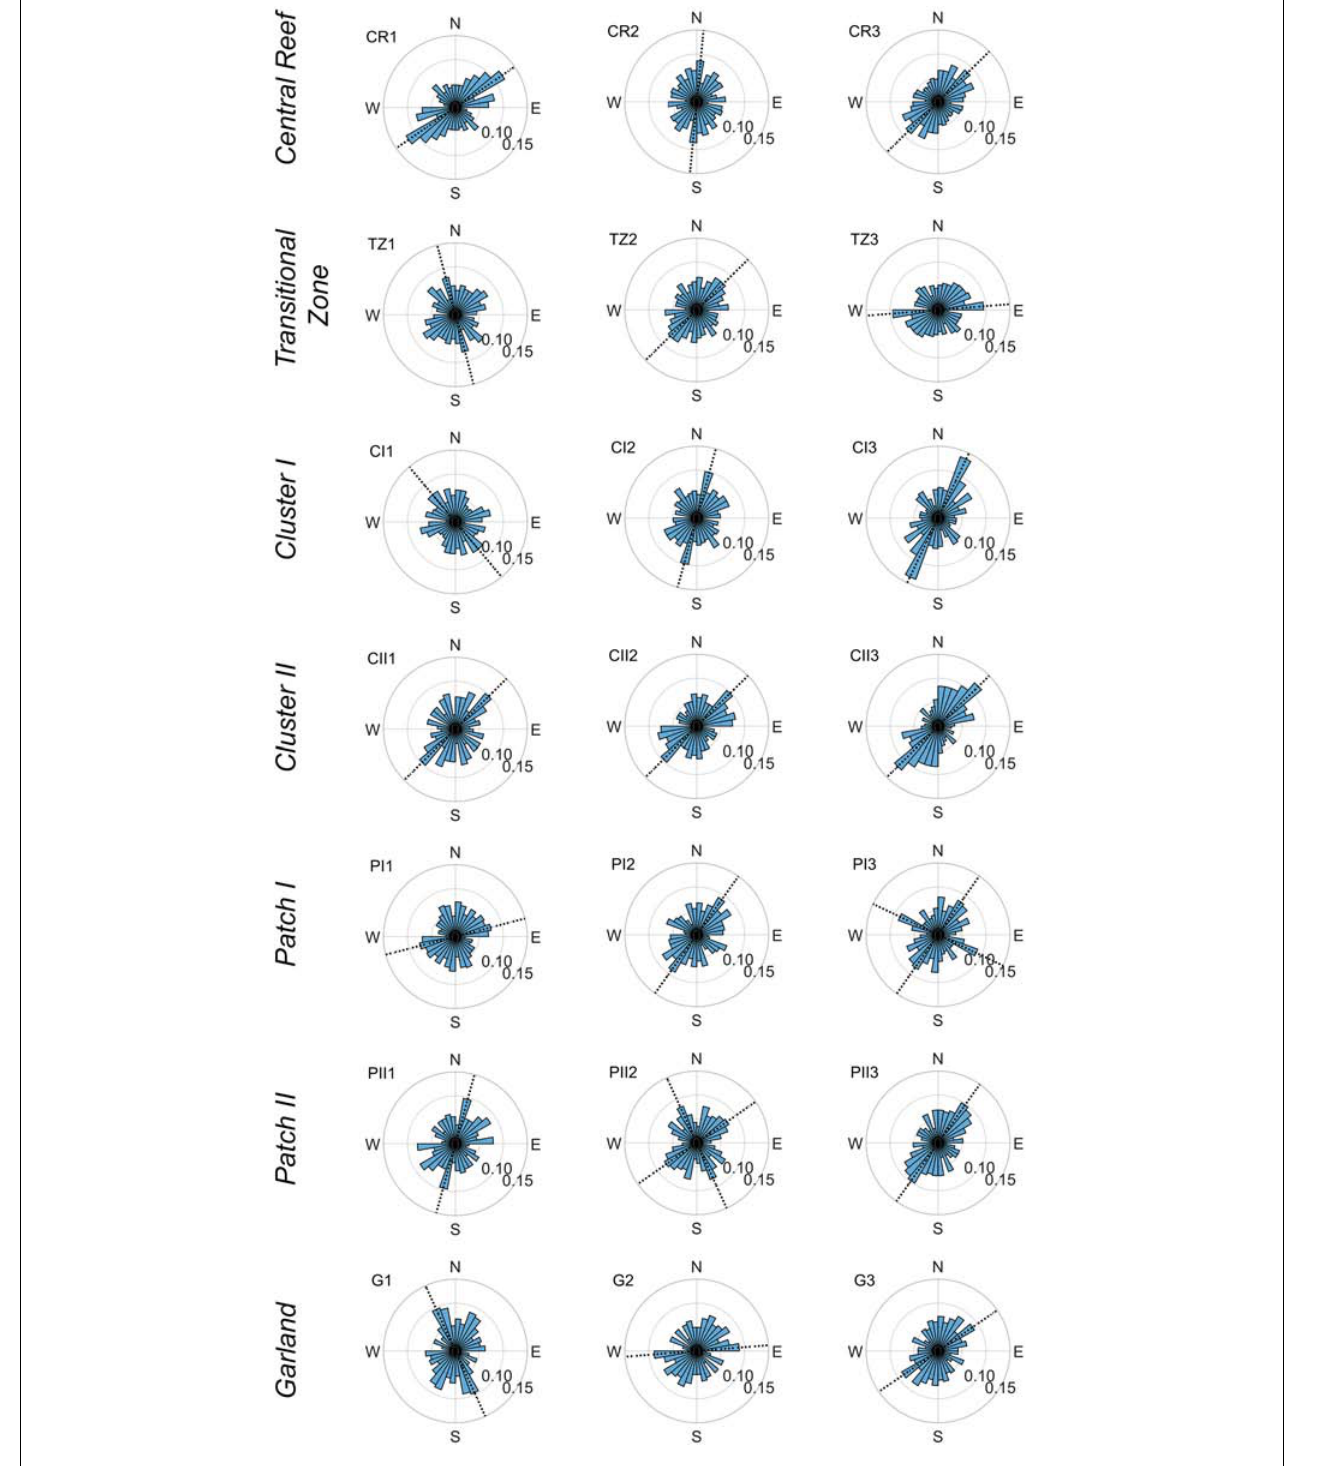
FIGURE 9 | Rose diagrams illustrating the dorso-ventral orientations of oyster shells and their respective frequency of the 21 samples sorted by proposed structural classes. The length of the bins represents the number of oysters oriented in that direction normalized by the total number of oyster shells in the sample. Each bin covers a range of 10 ◦ . The samples are mirrored along the north-south axis for illustration purposes. Dashed lines show the major orientation φ Shells [ ◦ ].